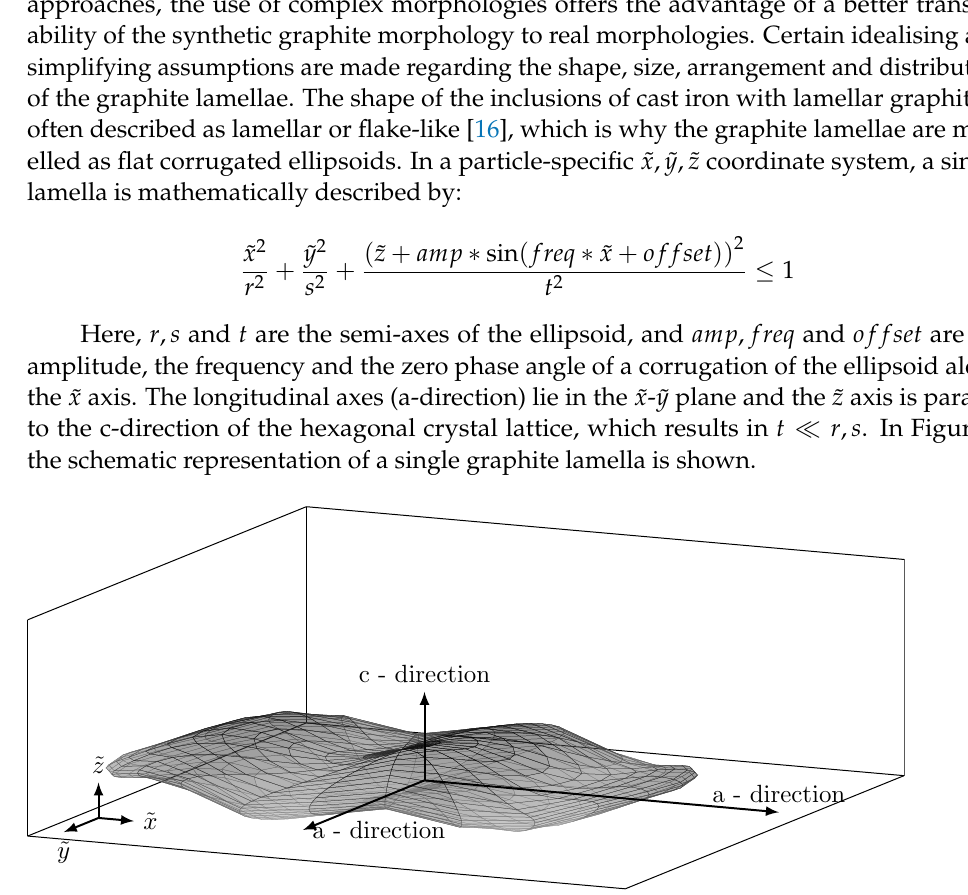
Figure 1. Schematic representation of an idealised graphite lamella, in the form of a flat corrugated ellipsoid. The ellipsoid is shown in the particle’s own ˜ x , ˜ y , ˜ z coordinate system and the axes of the hexagonal crystal lattice are